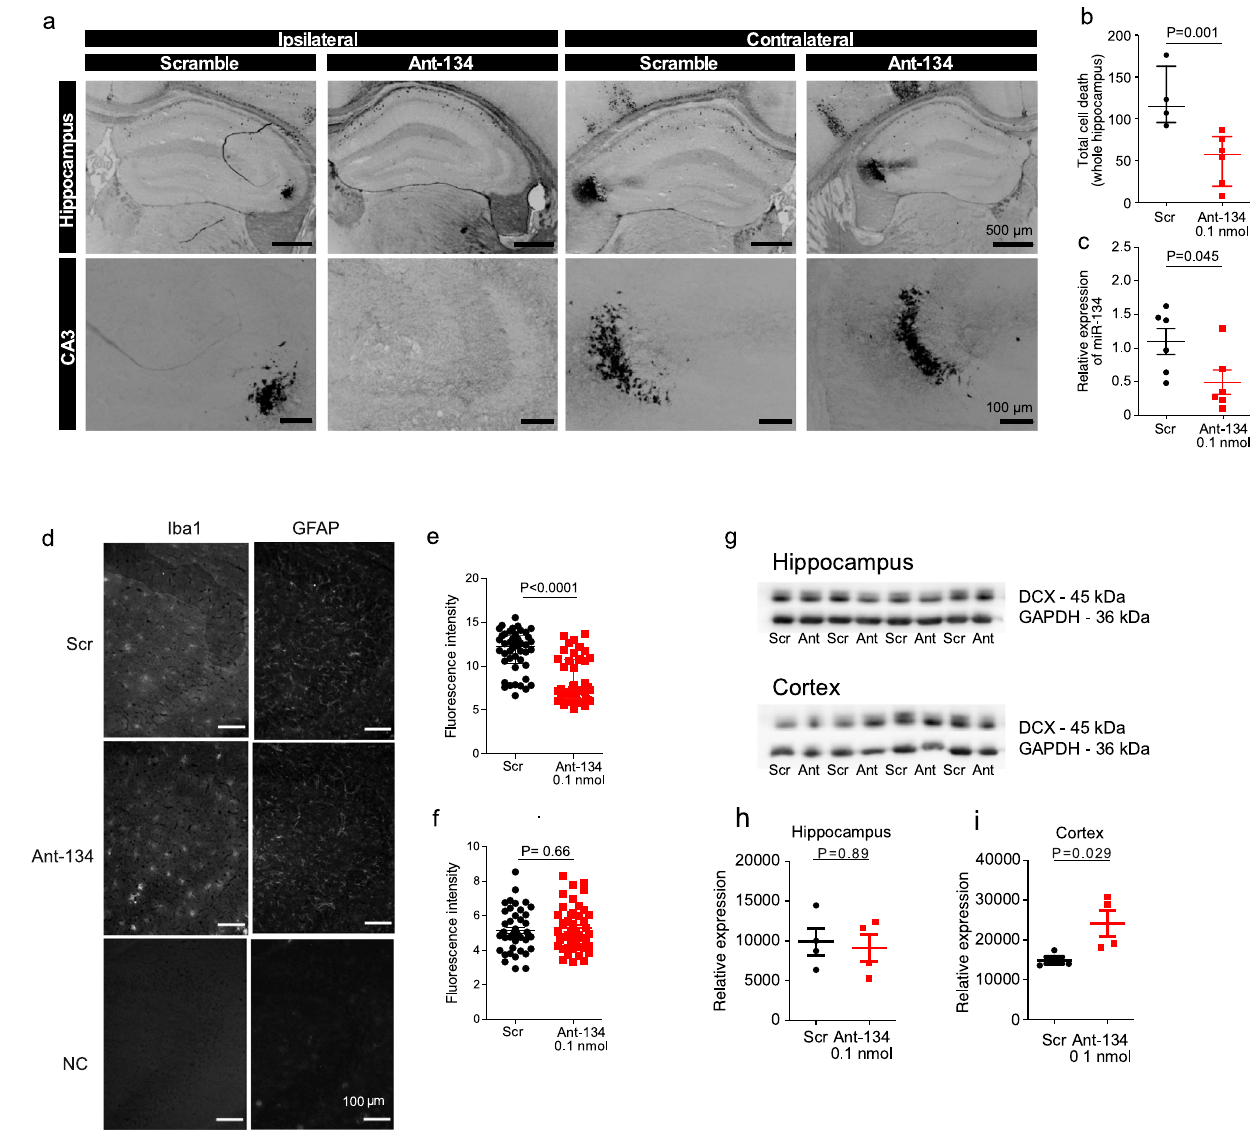
Figure 6. Ant-134 has protective effects in the hippocampus and de-represses cortical DCX. ( a ) Representative FJB-stained images show neuronal death in the hippocampus 24 h after SE ipsi- and contralateral to pre- treatment with 0.1 nmol Ant-134 or scramble control (Scr). ( b ) The number of FJB-stained cells was reduced in mice pre-treated with Ant-134 (N = 6) compared with scramble control (N = 4). ( c ) Partial knockdown of miR- 134 levels (54.8%) was retained 24 h after SE in the hippocampus of mice that were pre-treated with 0.1 nmol Ant-134 (N = 6) or Scr (N = 6). ( d ) Representative immunohistochemistry staining with Iba1 and GFAP in the CA3 of the hippocampus after SE. ( e ) The number of activated microglia was decreased in mice pre-treated with Ant-134 (N = 3) compared with scramble control (N = 3). ( f ) There was no difference in the number of astrocytes in mice pre-treated with Ant-134 (N = 3) and scrambled control (N = 3). ( g ) Western blot showing DCX expression in hippocampus and cortex at 24 h after KA-induced seizures of mice pre-treated with Scr/Ant-134 (0.1 nmol). Full-length blot can be found in Supplementary Fig. S3a. ( h ) Densitometry analysis of DCX in the hippocampus. GAPDH was used as the loading control, (N = 4/group). ( i ) Densitometry of DCX in the cortex. GAPDH was used as the loading control (N =